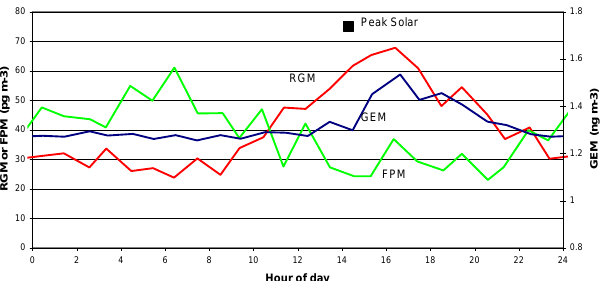
Fig. 3. Hourly diurnal averages for all 2007 campaign measure- ments.